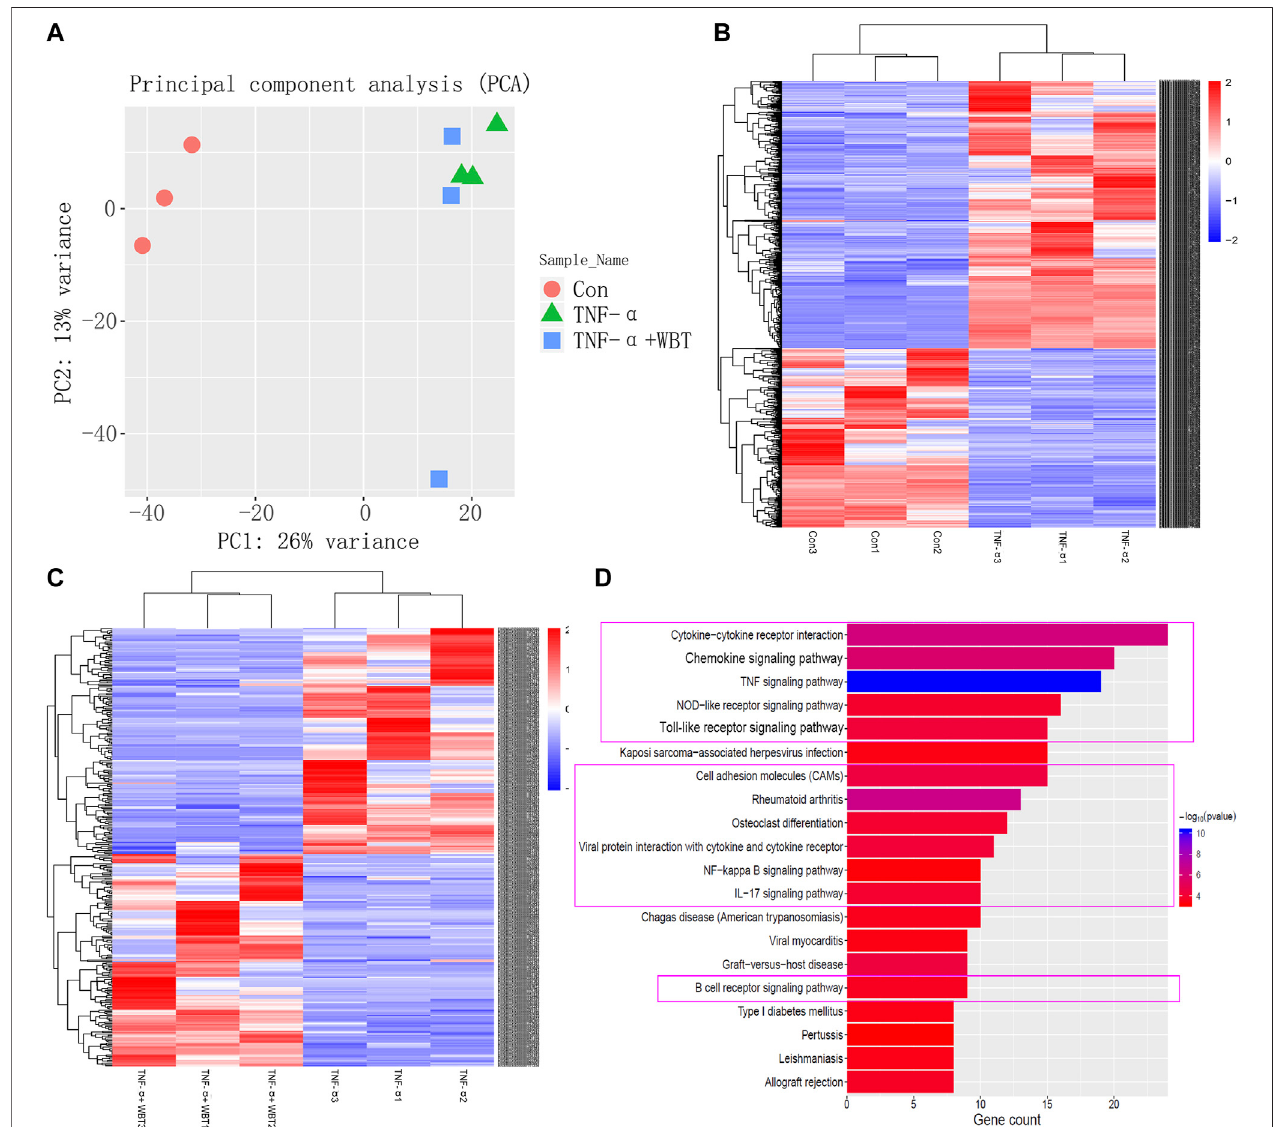
FIGURE 5 | RNA-seq transcriptional comparison between different groups, and functional enrichment analysis based on network pharmacology. Principal componentanalysisoftranscriptomesequencingresults (A) .Differentialgeneexpressionpro fi lesofTNF- α vs.Con (B) andTNF- α +WBTvs.TNF- α (C) werevisualizedin heat maps (fold change ≥ 2, p < 0.05). Pathway enrichment analysis of the hub genes responsible for the anti-in fl ammatory effect of WBT. The purple box indicated the pathways closely related to the occurrence and development of RA (D) .